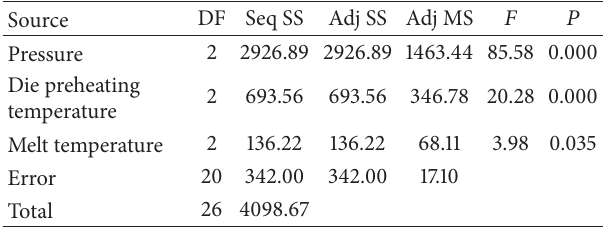
Table 9: Analysis of variance for YS, using adjusted SS for